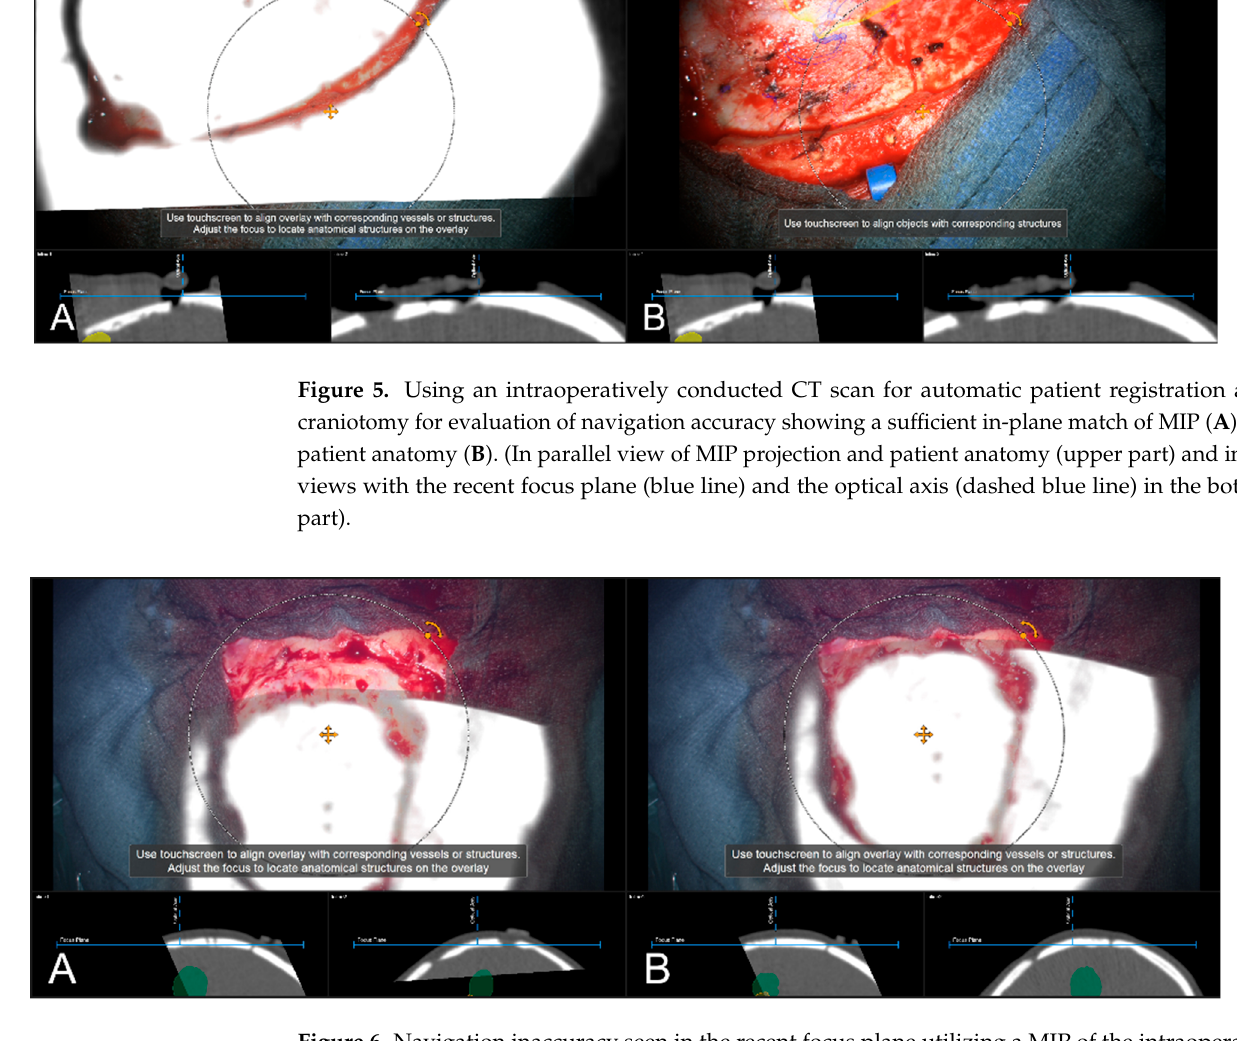
Figure 6. Navigation inaccuracy seen in the recent focus plane utilizing a MIP of the intraoperative automatic registration CT image set acquired after craniotomy showing the translational mismatch of MIP and patient anatomy ( A ) and the match of MIP and patients anatomy in the recent focus plane after manual correction (translation) of the visual misalignment ( B ). (In parallel view of MIP projection (upper part) and inline views with the recent focus plane (blue line) and the optical axis (dashed blue line) in the bottom part).